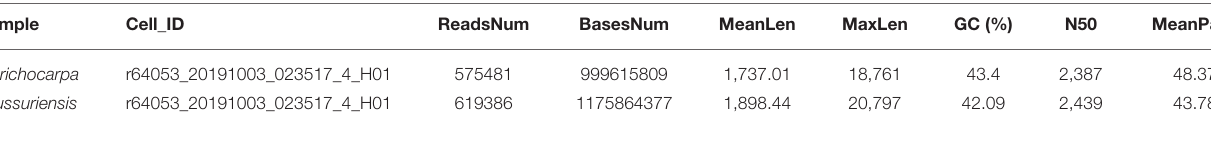
TABLE 2 | Statistical analysis of circular consensus sequences